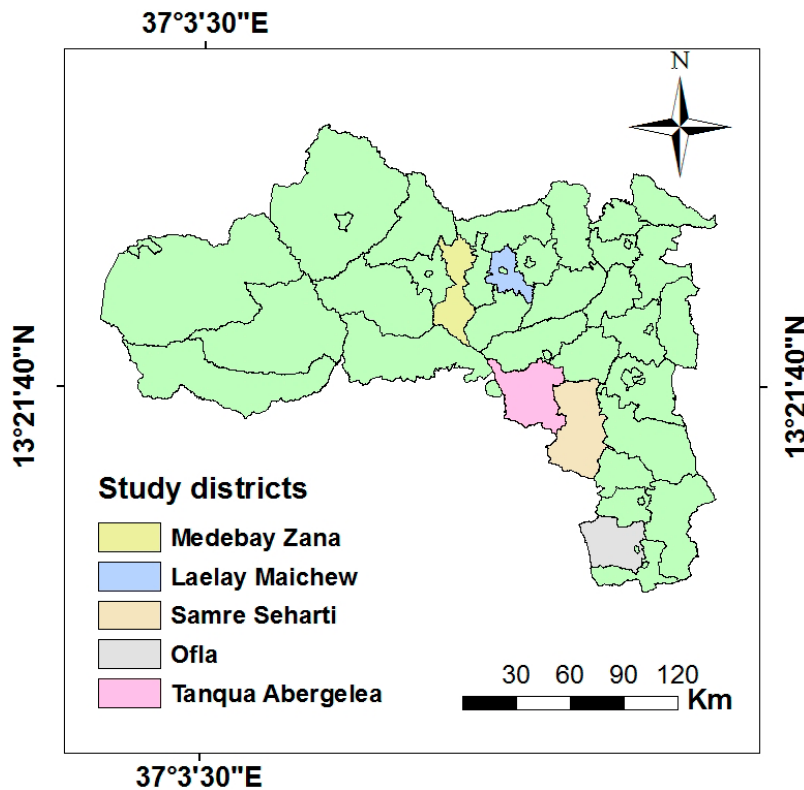
Figure 1. Study districts from the Tigray Administrative region, Northern Ethiopia.